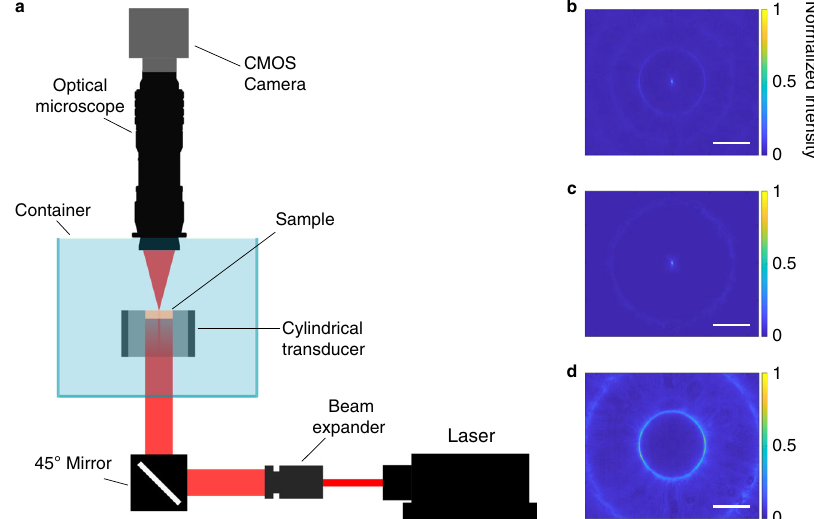
Fig. 2 Light is con fi ned by pressure patterns. a Schematic of the characterization setup. Experimental 2D cross-section image of the optical beam pro fi le b with ultrasound and laser light not synchronized, c with ultrasound and laser light synchronized and phase locked at + 90° to form only the central waveguide and d with the phase shift at − 90° to form only the ring waveguide. The intensity of each 2D cross-section is normalized to its maximum value. The scale bar is 1